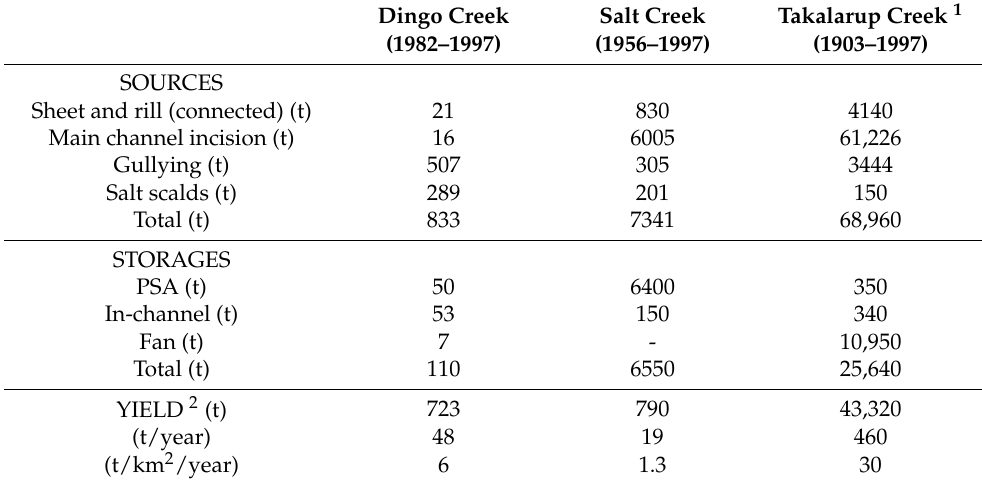
Table 4. Sediment Budget for Dingo Creek and Salt Creek catchments, with the budget for the Takalarup Creek catchment for